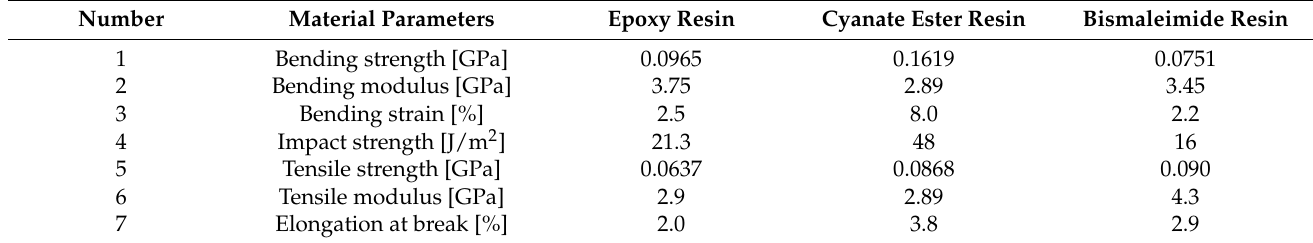
Table 2. Performance parameters of typical thermosetting resins.